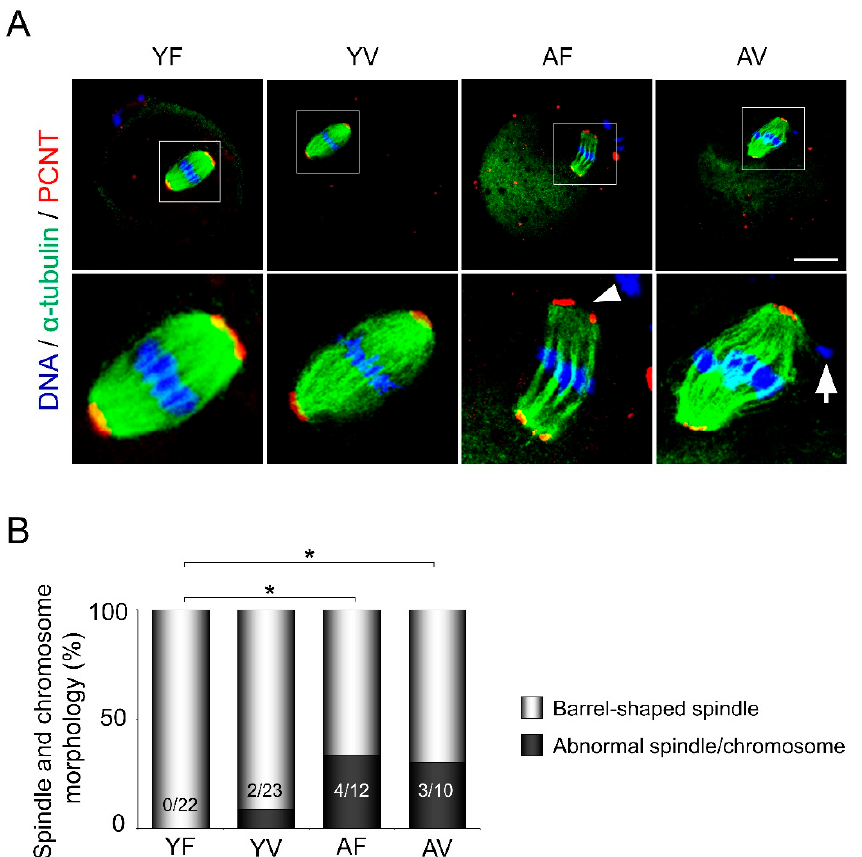
Figure 2. Abnormal spindle and chromosome organization in oocytes from aged mice. ( A ) Representative images of immunofluorescence staining for α -tubulin (a spindle marker, Green), pericentrin (PCNT; a spindle pole marker, Red), and DAPI (DNA, Blue) in oocytes from young and aged mice with or without vitrification. The bottom panels show the enlarged images of the boxed areas in the upper panels. Arrowhead and arrow indicate abnormal spindle/spindle pole and chromosome, respectively. Note that abnormal spindle and chromosome organization were often observed in oocytes from aged mice. ( B ) Quantitative analyses of oocytes with abnormal spindle and chromosomal morphologies ( n = 10–23 oocytes in each group). White and black bars represent the percentage of oocytes with normal and abnormal morphologies, respectively Scale bar = 20 µm. Statistical analyses were performed using Fisher’s exact test. * p < 0.05. YF: Young fresh, YV: Young vitrified, AF: Aged fresh, AV: Aged vitrified.